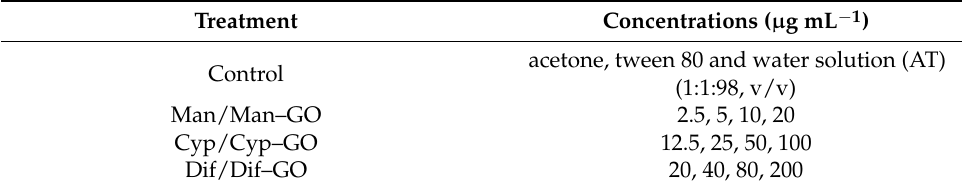
Table 1. Treatments with single Man, Cyp and Dif or in combination with GO against F. graminearum .